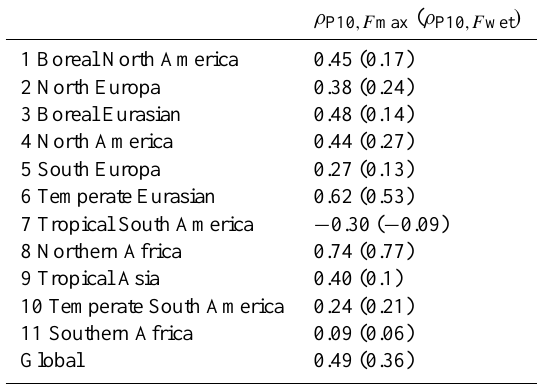
Table 3. Spearman correlation ( ρ P10 ,F max ) between the inundated (P10) and fractions at maximum soil water content ( F max ) at the annual maximum (regardless of the month of maximum) of the grid- cells contained in each region defined in Fig. 2b and at global scale. Similar correlations for F wet are indicated in brackets.